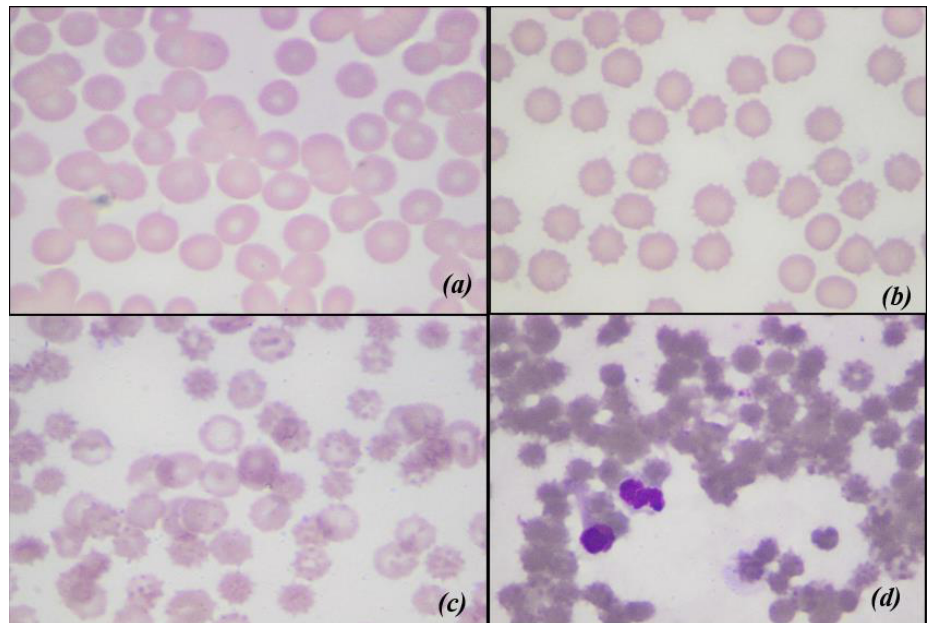
Figure 9. Optical microscopic scans of non-leukoreduced whole blood, showing morphological changes during storage. ( a ) corresponds to T0 red blood cells with normal biconcave disc shape; ( b ) corresponds to T14; ( c ) correspond to T28 and ( d ) corresponds to T42 progressive changes in shape. ( d ) also shows neutrophils in the degeneration phase.